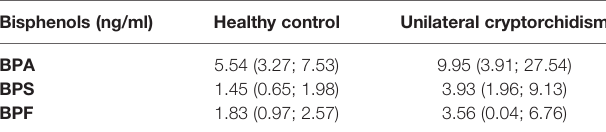
TABLE 2 | Bisphenols plasma levels in the unilateral cryptorchidism and healthy control group in reference to area of living a . Bisphenols